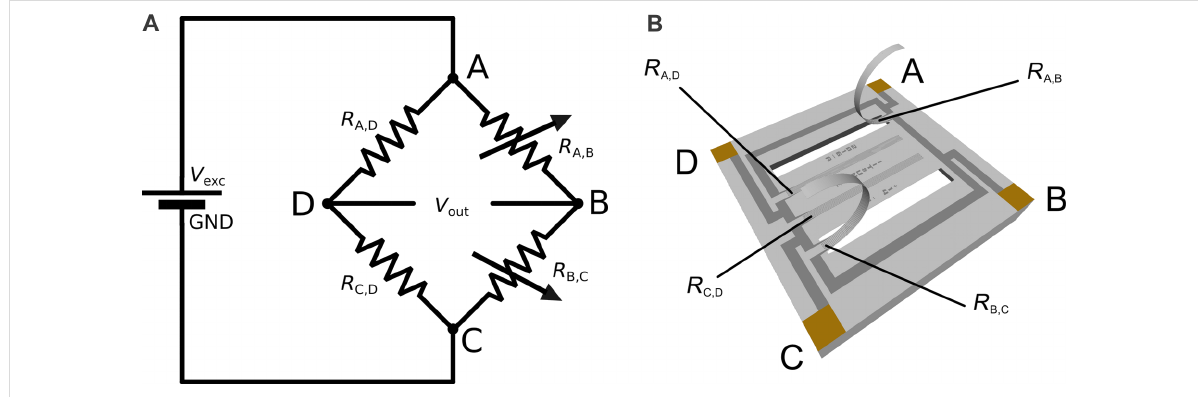
Figure 6: (A) Schema and (B) implementation of a Wheatstone half-bridge circuit with two static and two variable resistors (strain gauges).